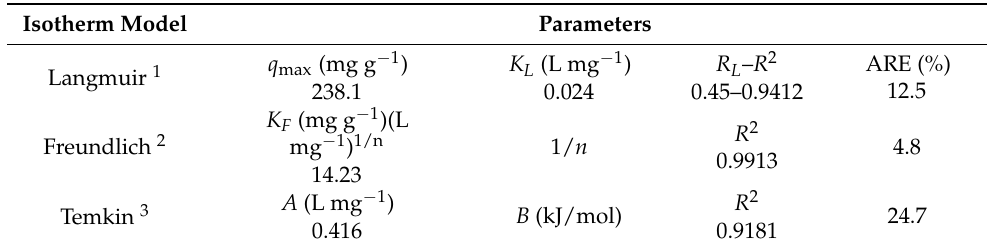
Figure 10. Fitting adsorption isotherm models for MB adsorption on biomass. Table 1. Isotherm models